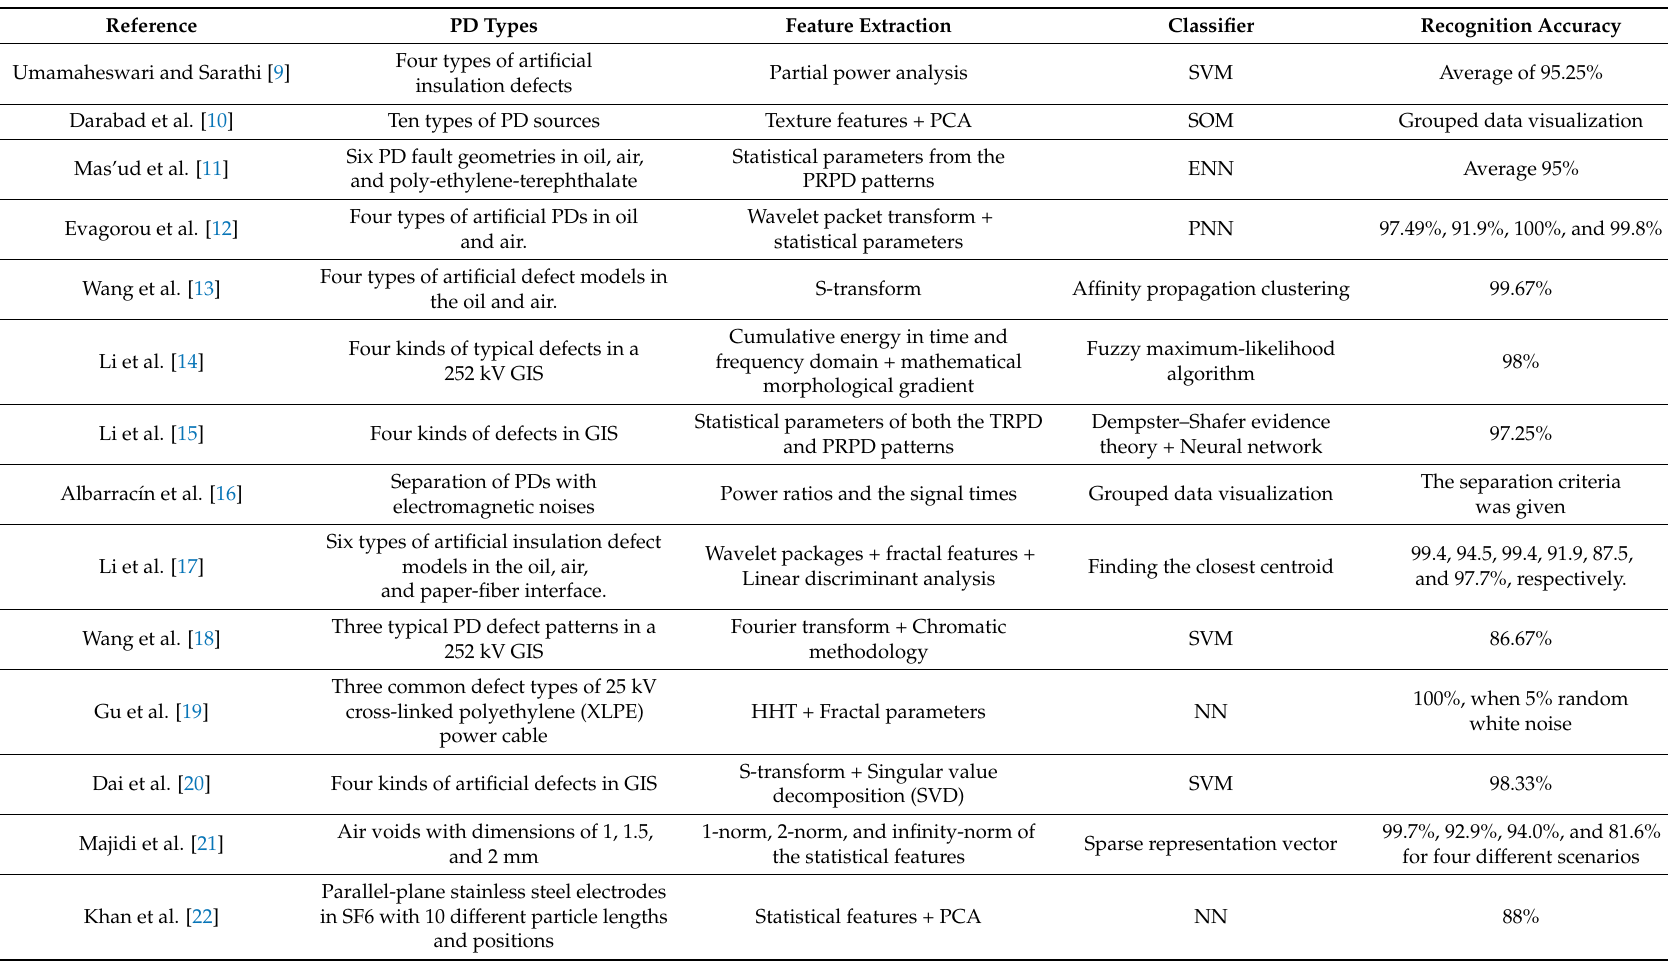
Table 1. Summary of the relevant features and classifiers that have been used for partial discharge (PD)